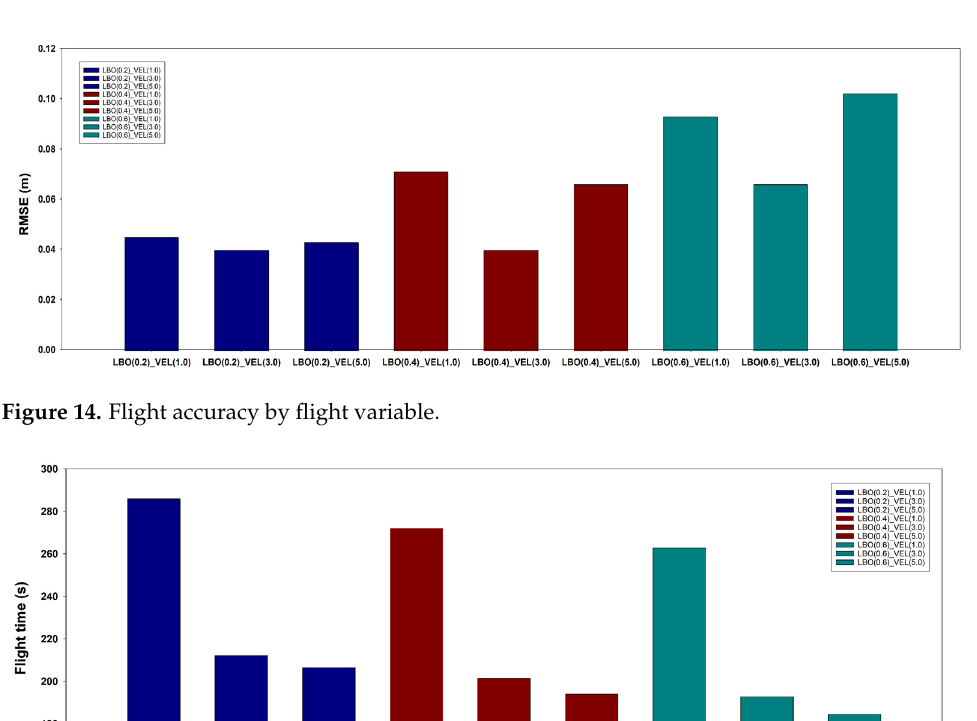
Figure 16. Flight altitude for each UAV during collision avoidance.